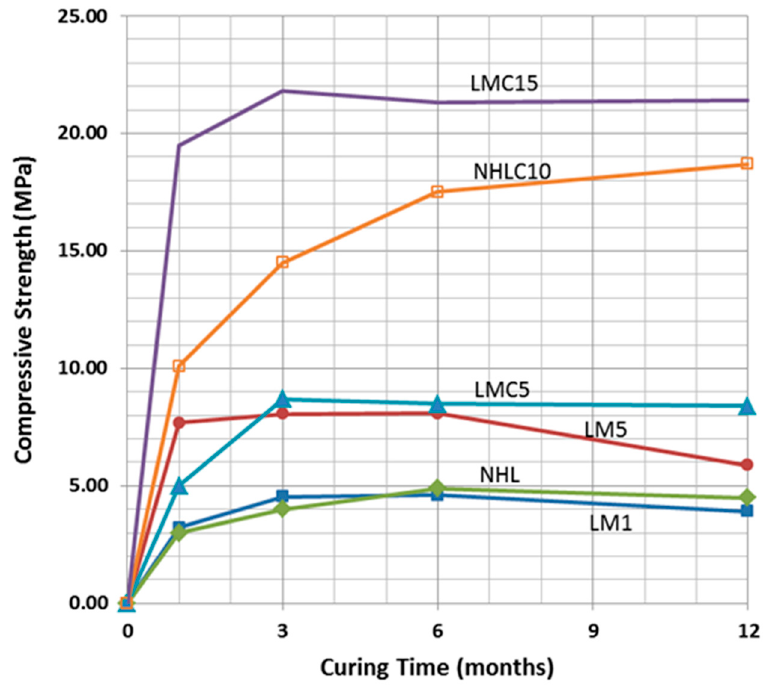
Figure 10. Compressive strength values (MPa) in relation to curing time (months); LM: lime metakaolin mortars, LMC: lime metakaolin concrete, NHL: Natural hydraulic lime mortar, NHLC: Natural hydraulic lime concrete. Table 6. Synthesis of selected restoration mortars [59,60].